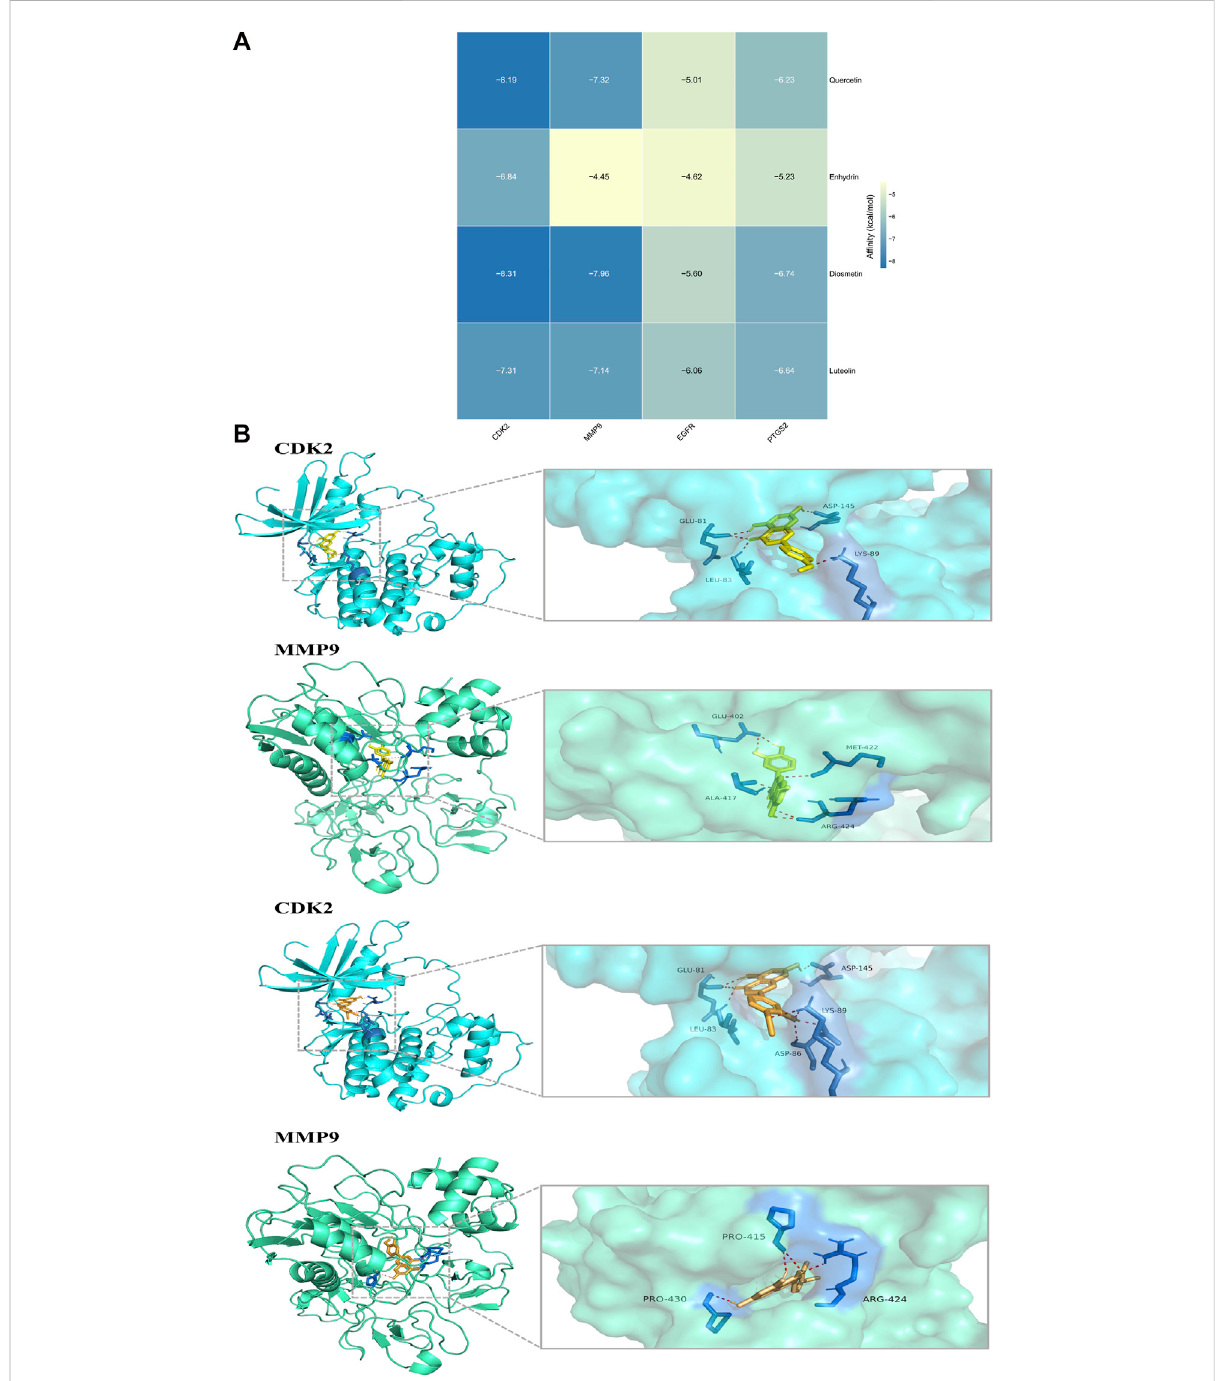
FIGURE 8 Molecular docking of four typical core compounds with four hub target proteins (A) The binding energy heatmap with a deeper color suggesting a more stable binding (B) The molecular docking between CDK2, MMP9 and quercetin or diosmetin. The yellow and orange ligands represented quercetin and diosmetin, respectively. The enlarged view on the right showed the interactions of ligands and amino acid residues of CDK2 and